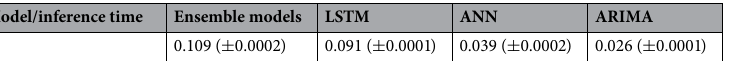
Table 11. Mean inference time (in second) of Ensemble models, compared with other